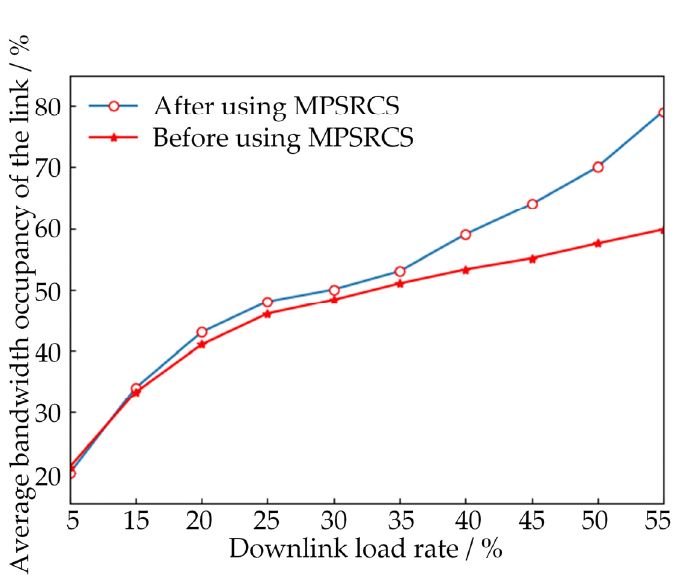
Figure 20. Terminal node module prototype.